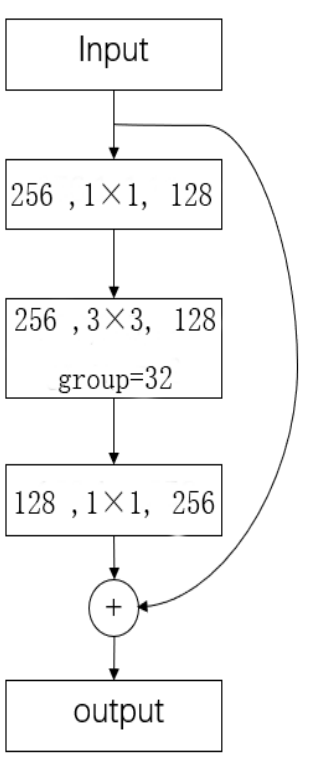
Figure 2. Block of